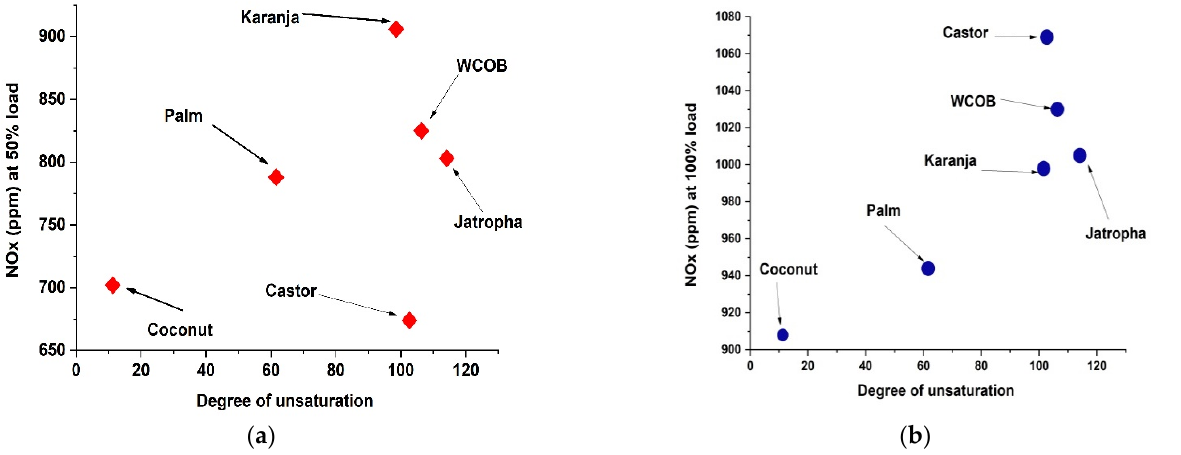
Figure 11. NOx gas emissions with as a function of DU: ( a ) 50% load and ( b ) 100%